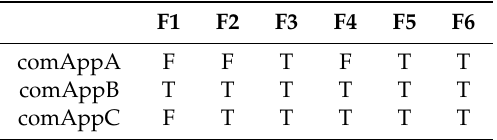
Table 1. Feature sets of comAppA, comAppB and